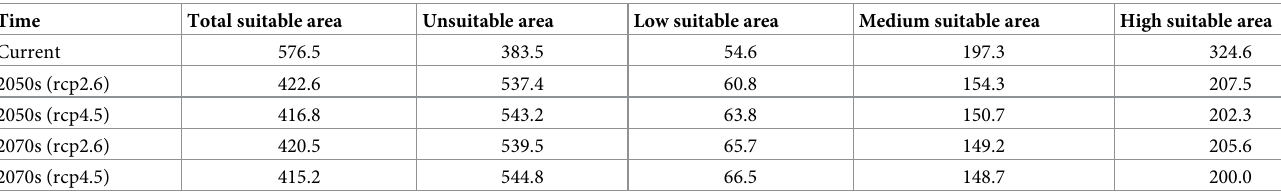
Table 4. Suitable areas of Pennisetum alopecuroides (L.) in different periods( × 10 4 km 2 ).